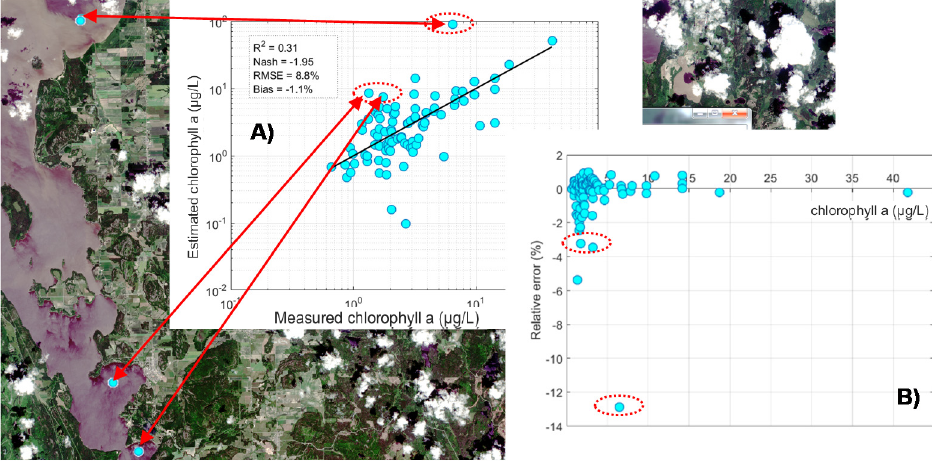
Figure 16. Assessment of the ensemble-based system: ( A ) using independent databases and ( B ) relative error results.